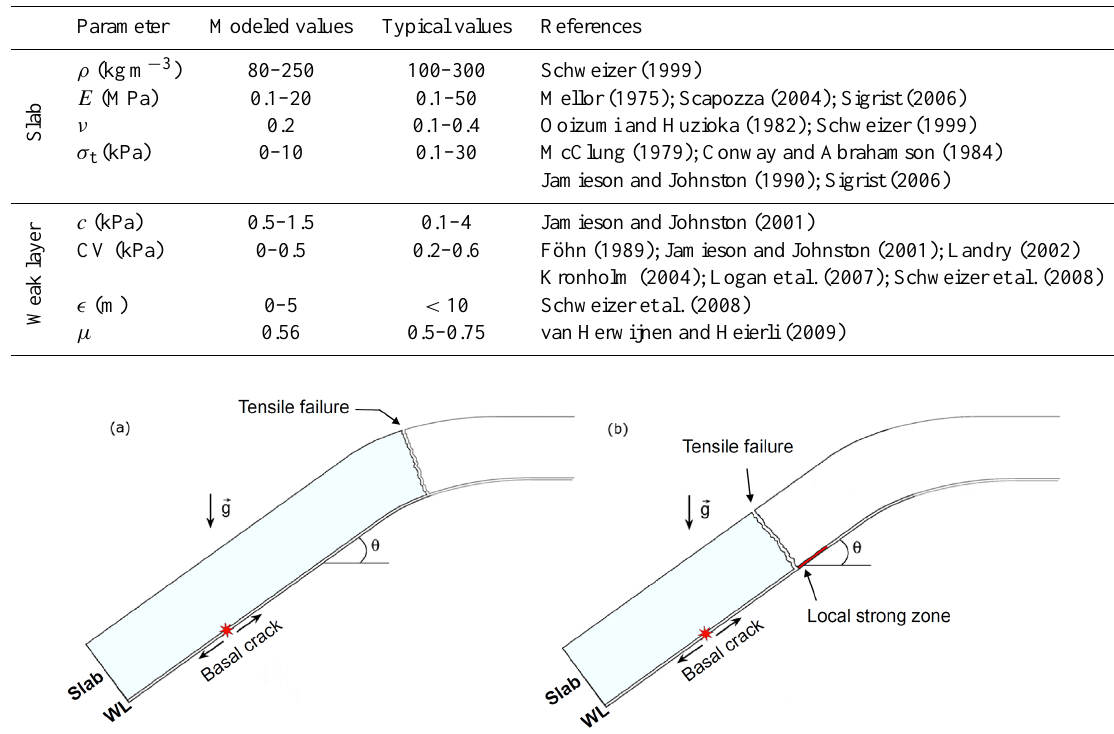
Table 1. Parameters used in the model and typical values for snow from field and laboratory experiments. For more details about these parameters and a more complete review of the different related studies, see Sect. 3.3.2 in Gaume (2012).